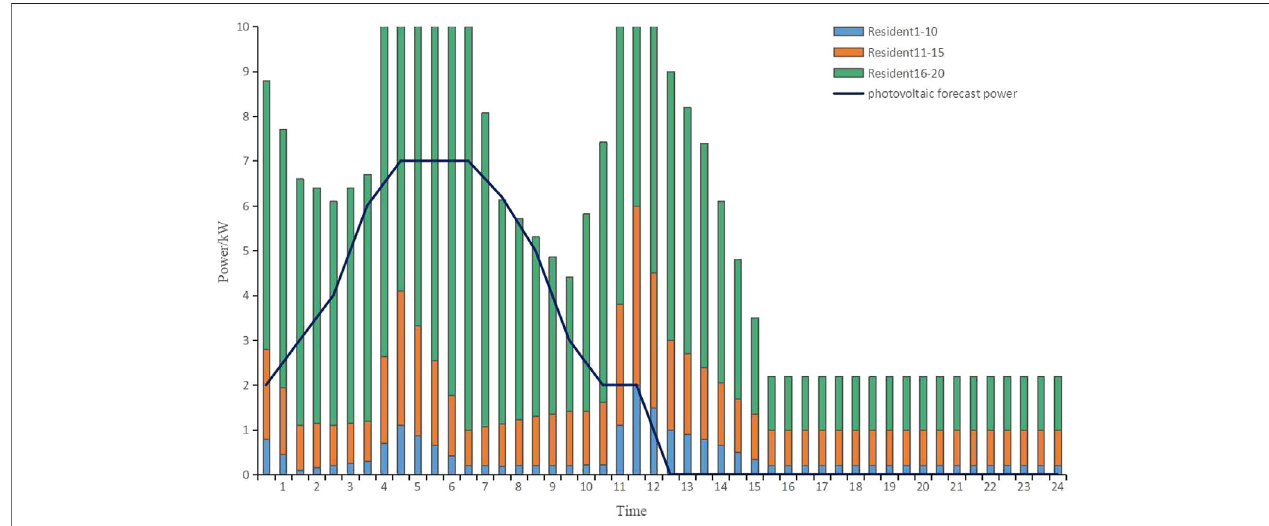
FIGURE 2 | Residents ’ load and photovoltaic forecast.